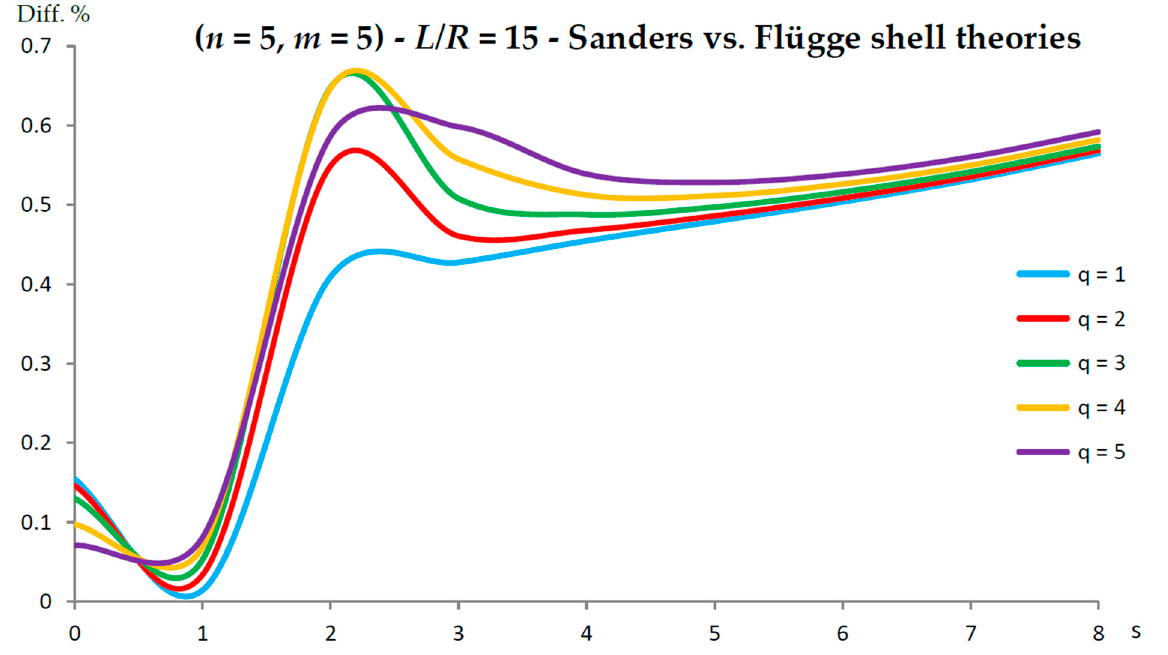
Figure 9. Percentage differences between the radial natural frequencies obtained via Sanders and Flügge shell theories (Flügge as the reference). Anisotropic elastic shell model. Simply supported SWCNT of Table 1 with chirality indices ( n = 5, m = 5 ) and aspect ratio L / R = 15. Number of longitudinal half-waves q . Number of circumferential waves s .